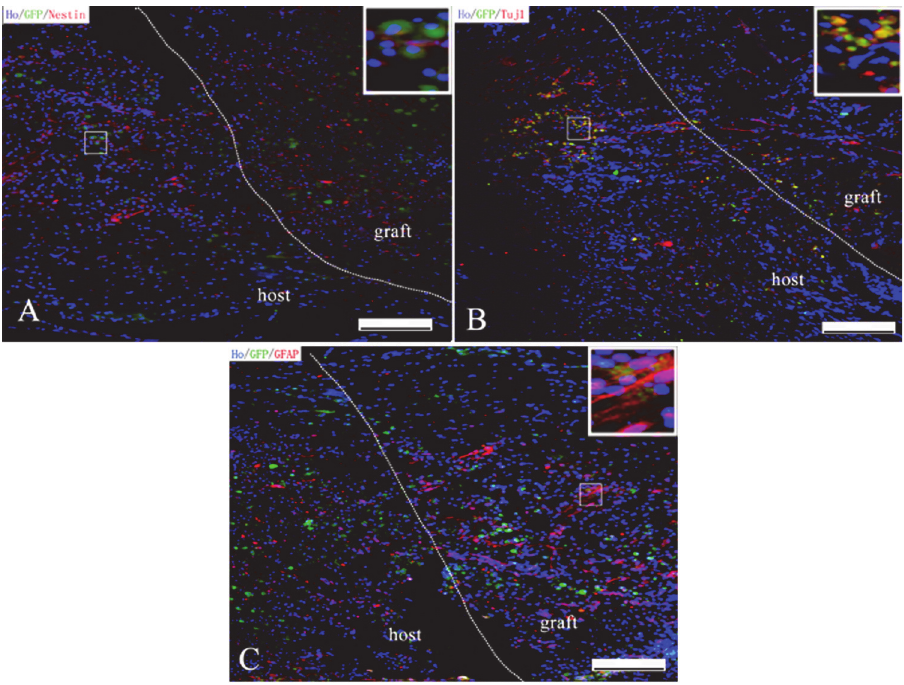
observed in graft site and surrounding spinal cord in PLGA-PEG group. Scale bars = 200 μ m (A-C).